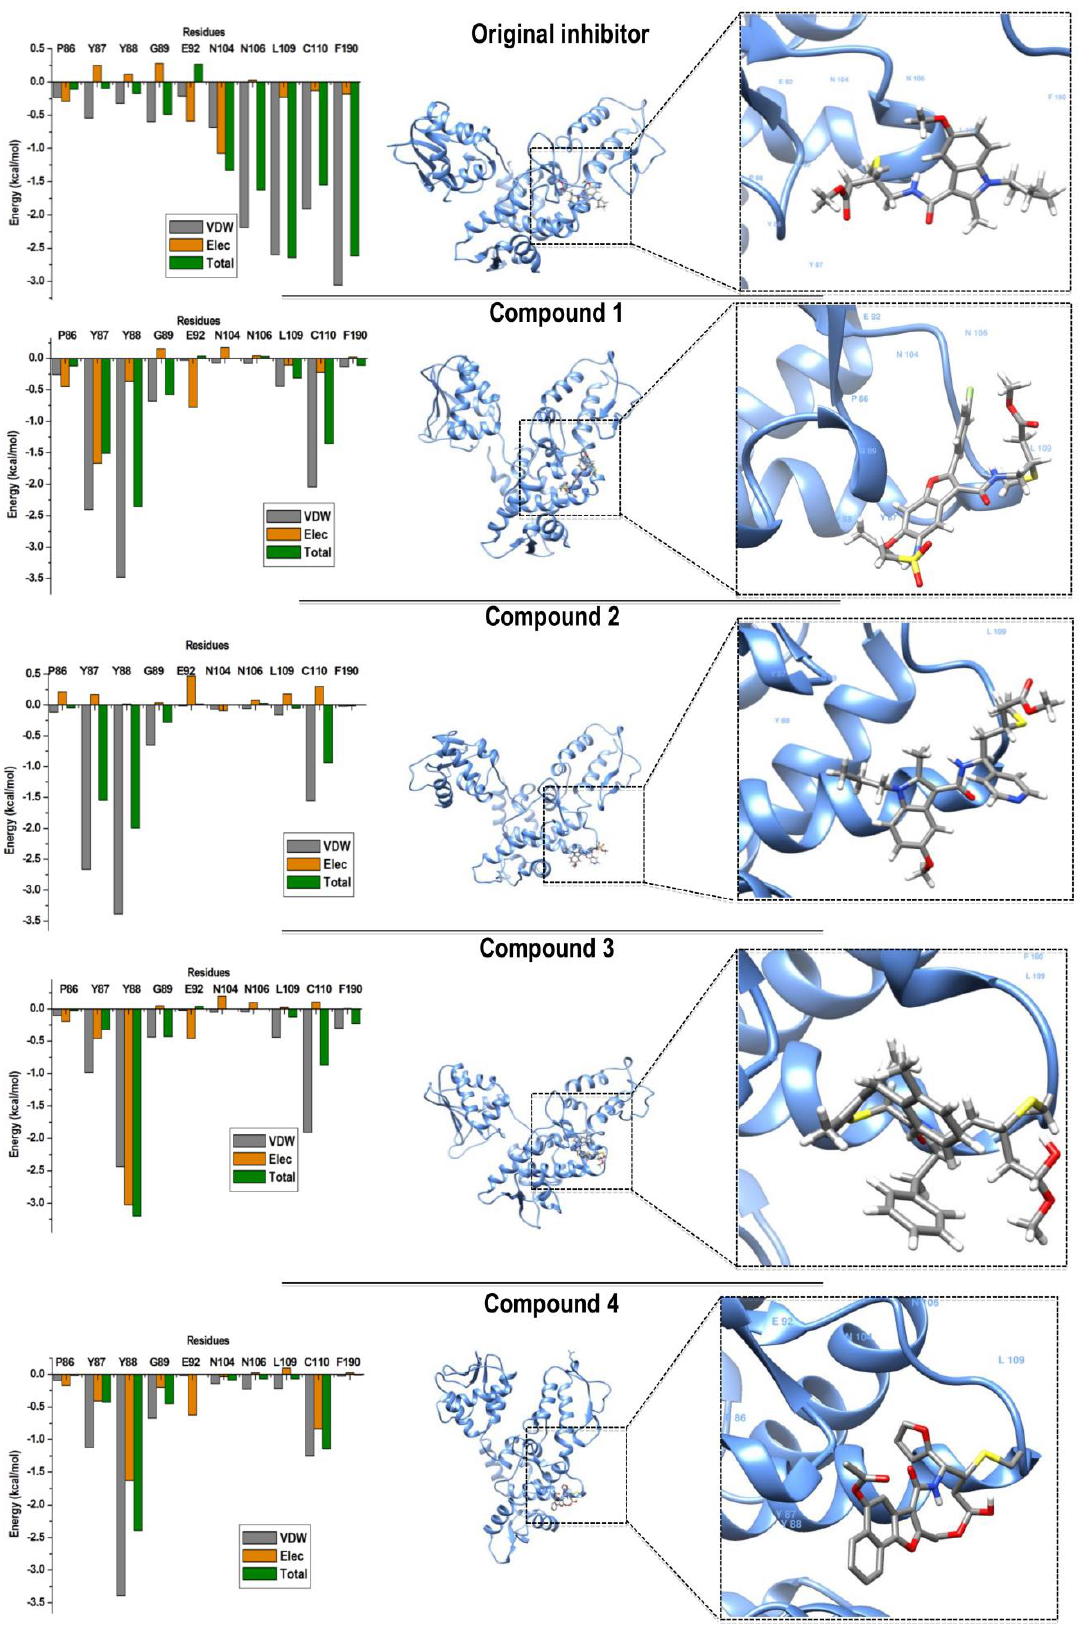
Figure 6. Per-residue decomposition analyses revealing individual energy contributions of allosteric site residues to the binding and stability of original compound and compounds 1 – 4 . Residues contributing the most to binding of all four compounds included TYR 87, TYR 88, and CYS 110.